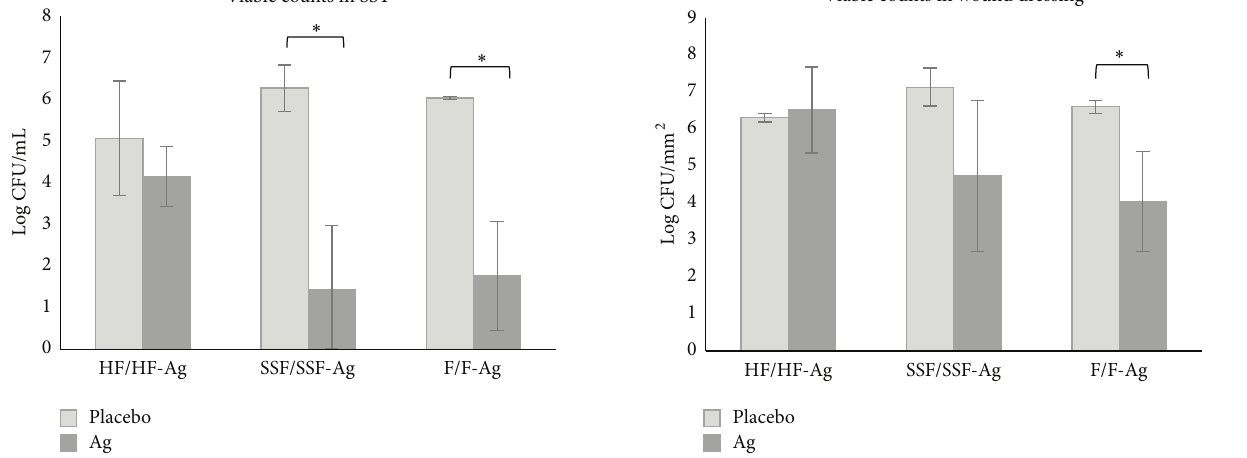
Figure 2: Graph showing bacterial load in 3D synthetic soft tissue (SST) after 24-hour exposure to wound dressings without (placebo) and with silver (Ag). Error bars show standard error of the mean (SEM) with 𝑛 = 3 for the placebo samples (except 𝑛 = 2 for F) and 𝑛 = 6 for the silver containing dressings. ∗ Significantly different from corresponding placebo at 𝑃 < 0.05 . Table 1: Log reduction of Pseudomonas aeruginosa (PAO1) in 3D synthetic soft tissue (SST) treated with silver containing test specimens in comparison to their placebos. Test specimens Log reduction